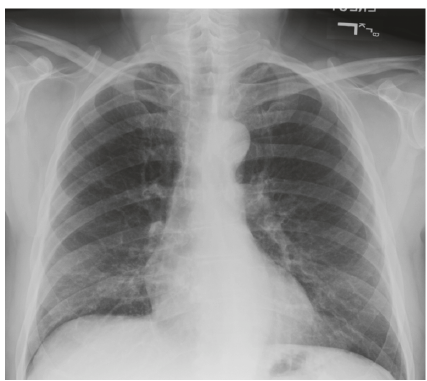
Figure 2: Postextubation chest x- ray showing resolution of the